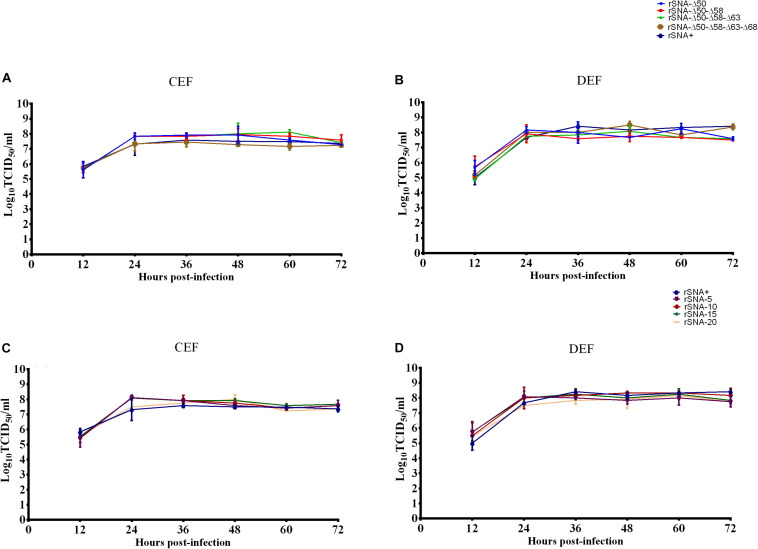
Growth curves of recombinant viruses in CEF (A,C) and DEF (B,D) cells. The mean and standard errors are shown from three independent experiments.